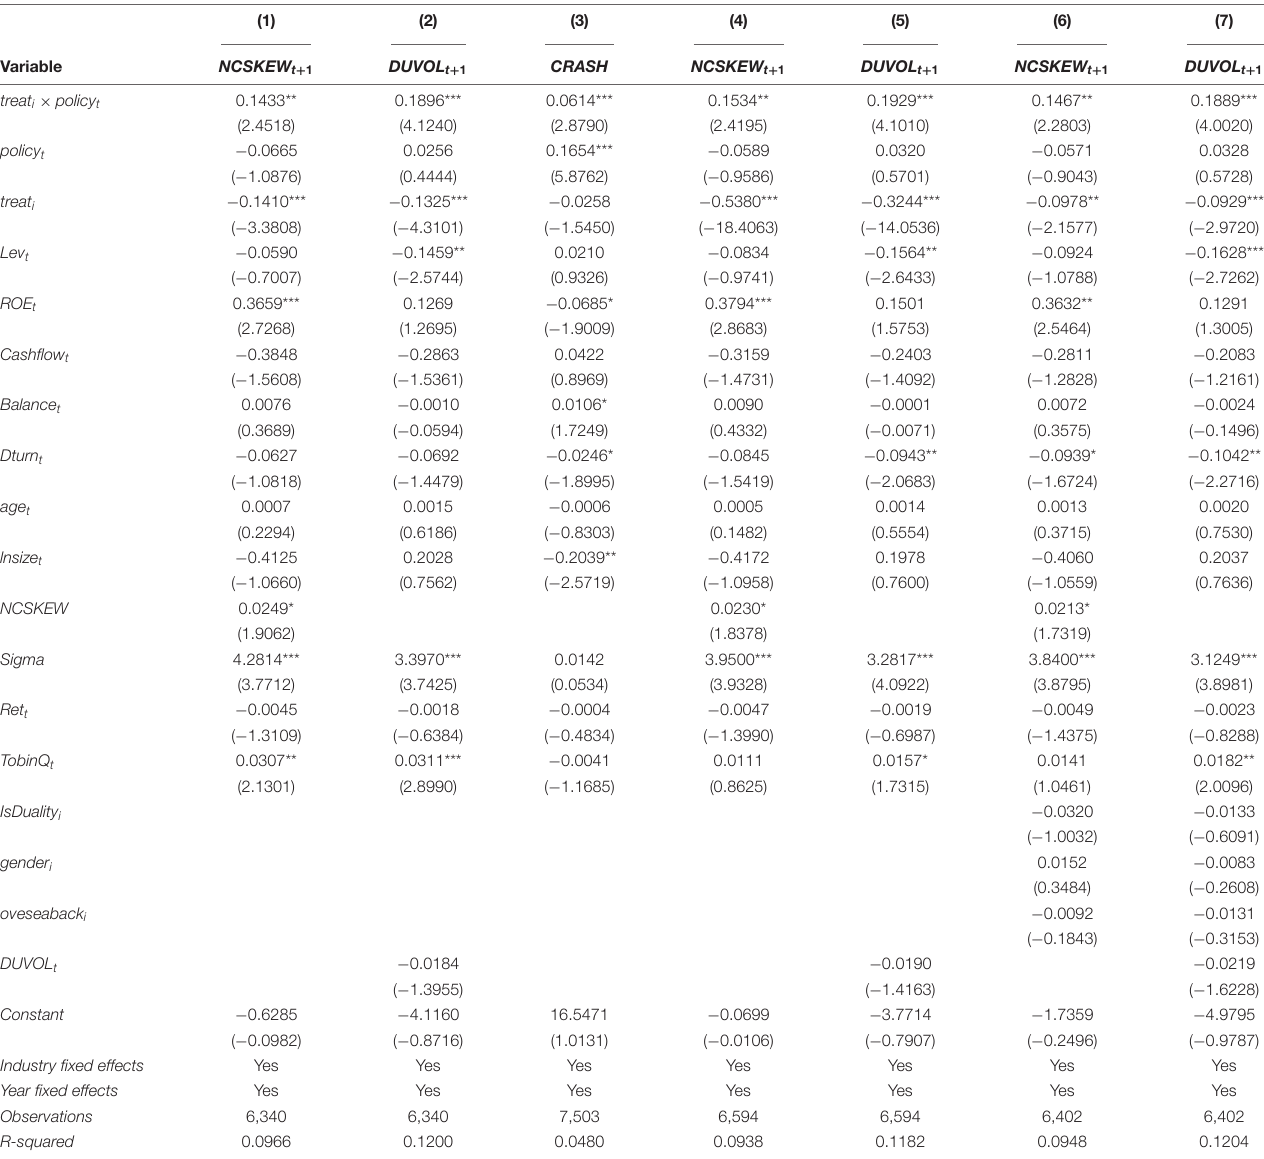
TABLE 5 | Robustness